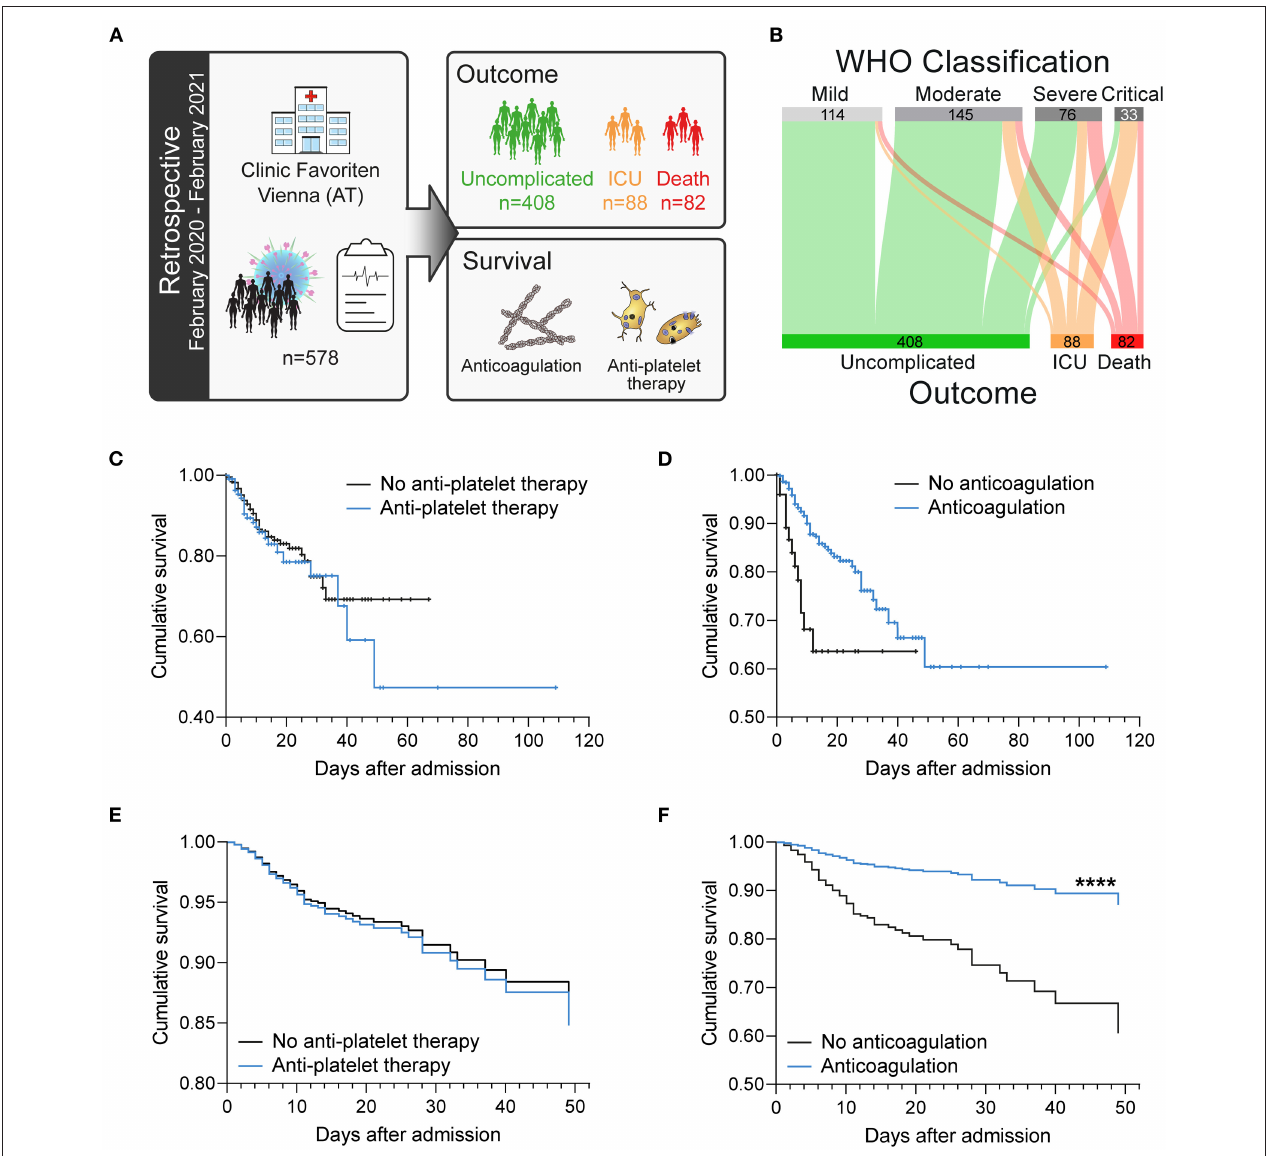
FIGURE 1 | Antiplatelet therapy does not affect the survival of patients with COVID-19 in a retrospective analysis after adjusting for age. (A) Retrospective study design: 578 consecutive patients with confirmed SARS-CoV-2 infection admitted to the primary COVID-19 hospital in Vienna, Austria were included in this longitudinal study and retrospectively analyzed. (B) Severity classification according to WHO guidelines is not stringent for fatal outcome. (C–F) Effect of (C,E) antiplatelet therapy (aspirin and/or P2Y 12 blockers) or (D,F) anticoagulation (LMWH and/or NOAC) on survival. (C,D) Kaplan–Meier curves. (E,F) Age-adjusted COX regression analysis. **** p < 0.0001. n = 578